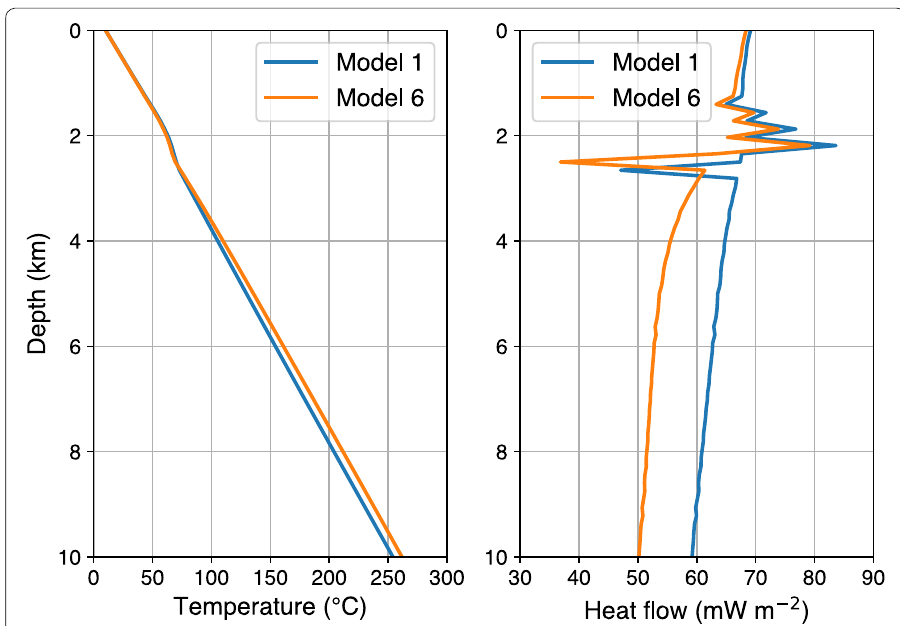
Fig. 15 Temperature and heat flow profiles at the center of Models 1 and